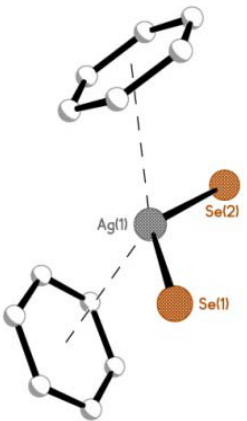
Figure 4. The bent metallocene motif found at the center of complex 1 , formed from two η 6 -S(phenyl)···Ag interactions. Comparative fragments found in complexes 2 and 3 are displayed in Figure S1,